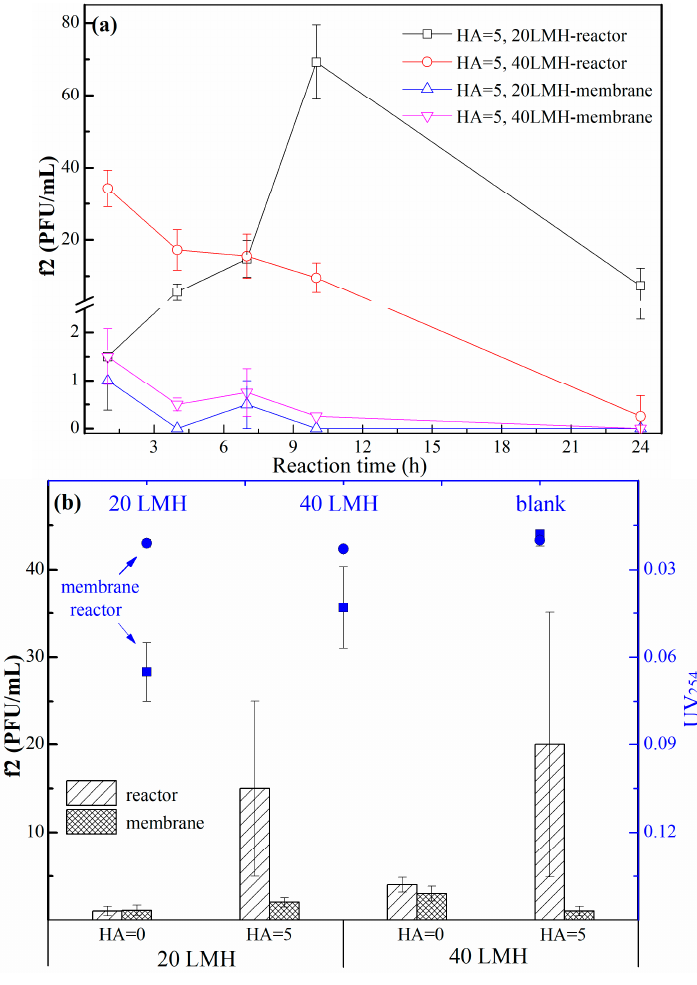
Figure 6. The changes of phage f2 in different reaction time ( a ) and effect of humic acid on photocatalytic disinfection and changes of UV 254 under different L/(m 2 ·h) (LMH) condition in water ( b ).